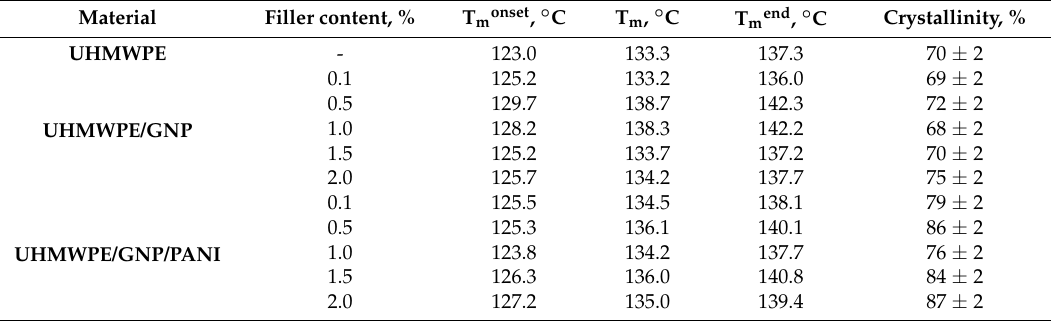
Table 1. DSC test results for the UHMWPE xerogels ( ± the standard deviation). Material Filler content, % T monset , ◦ C T m , ◦ C T mend , ◦ C Crystallinity, %